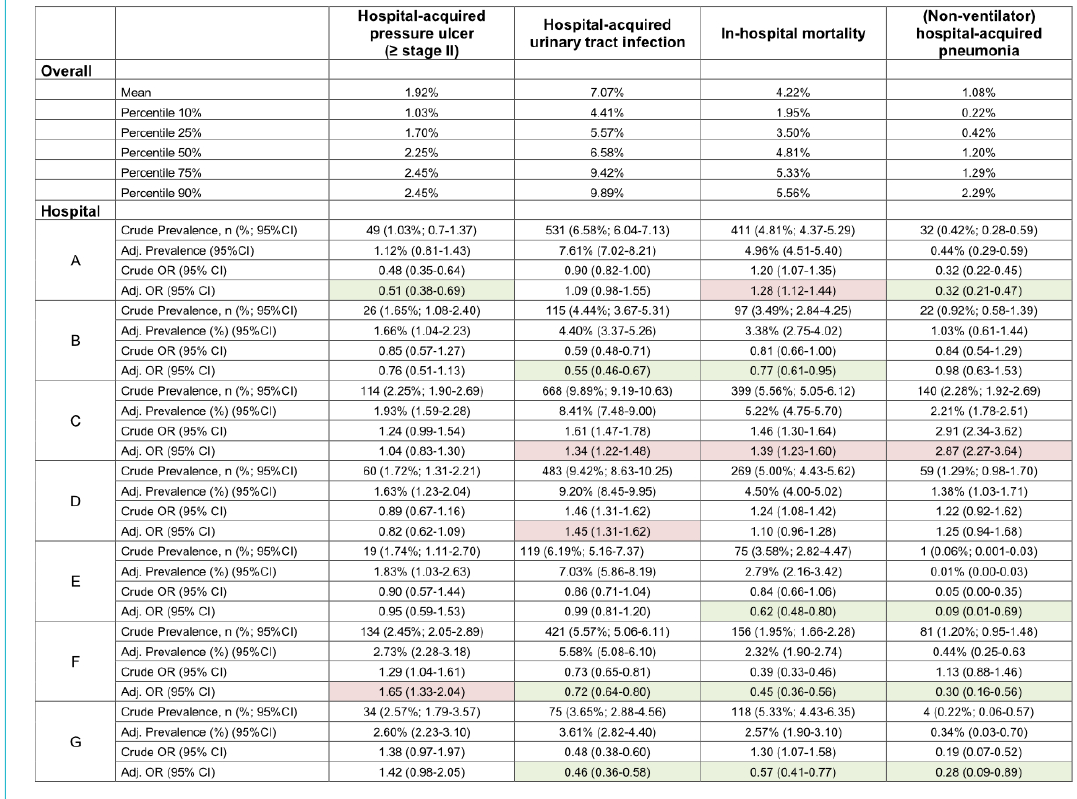
Figure 2: Crude and adjusted association of the nursing-sensitive outcomes between the participating hospitals. Marked green: significantly lower odds compared to all other hospitals Marked red: significantly higher odds compared to all other